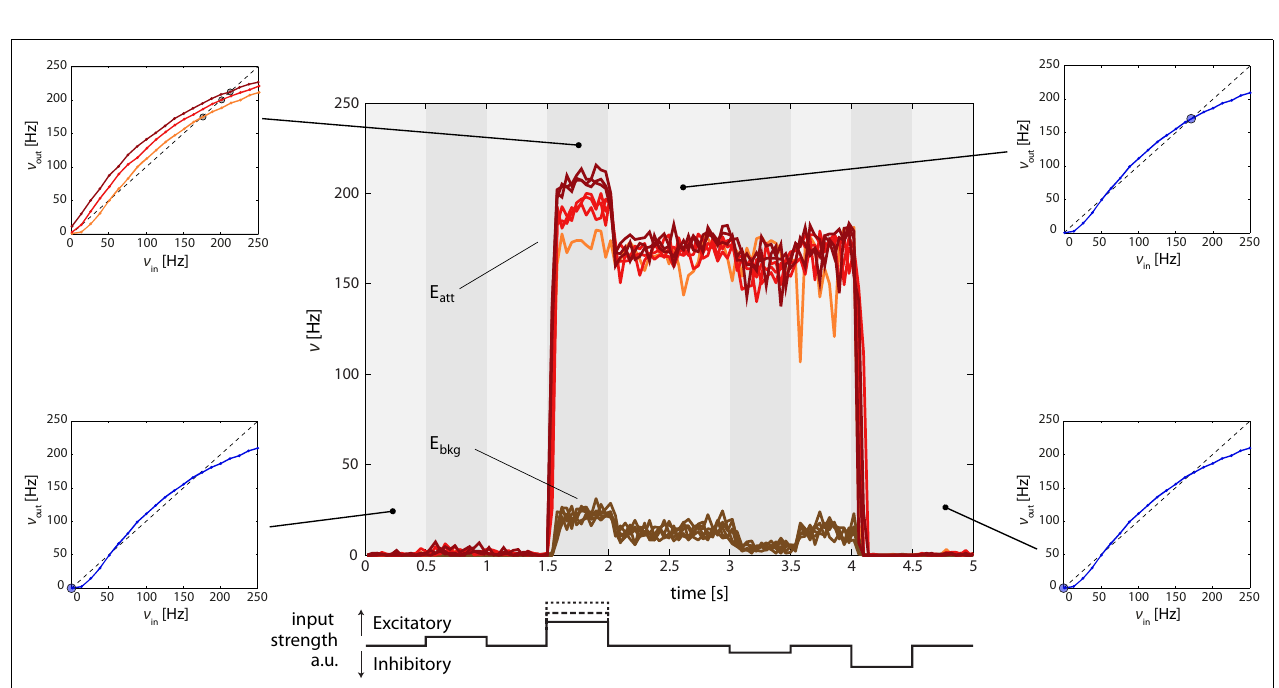
the other meta-stable state. All observations are predicted by the analysis of effective response functions (ERFs, insets on either side of central figure) measured on-chip. In the absence of input transients, the default ERF predicts two meta-stable fixed points, one “low” state (blue dot, bottom insets) and one “high” state (blue dot, top right inset). In the presence of input transients, the ERF is altered (orange, red, and burgundy curves, top-left inset) and the position of the meta-stable “high” state is shifted (orange, red, and burgundy